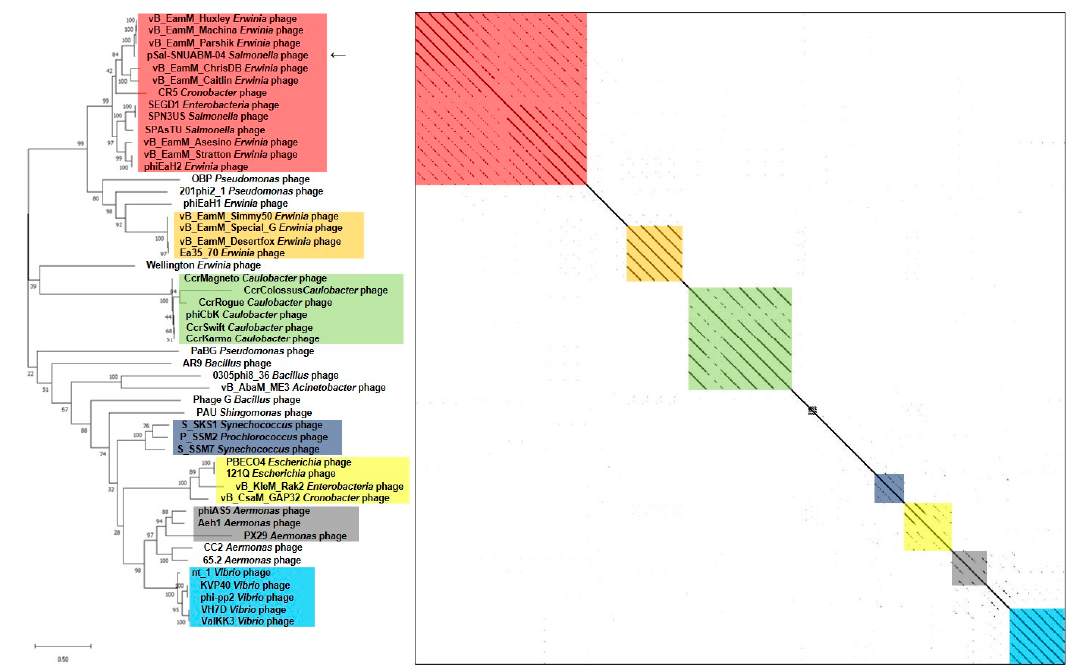
Figure 6. Comparative analysis of pSal-SNUABM-04 using terminase large subunit sequences. The phylogenetic tree was constructed using MEGA-X by maximum likelihood with 1000 bootstrap replications. The dot plot was generated with Gepard software at a word size of 10.